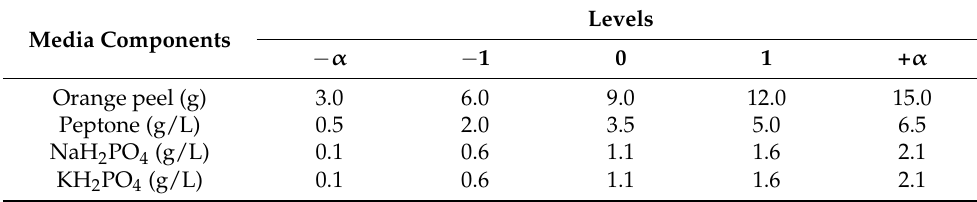
Table 4. The analysis of variance (ANOVA), Pareto chart, main effect plot, 3D response surface diagram, and 2D contour plot were obtained using Minitab 17 software. Table 4. The levels of media components used in